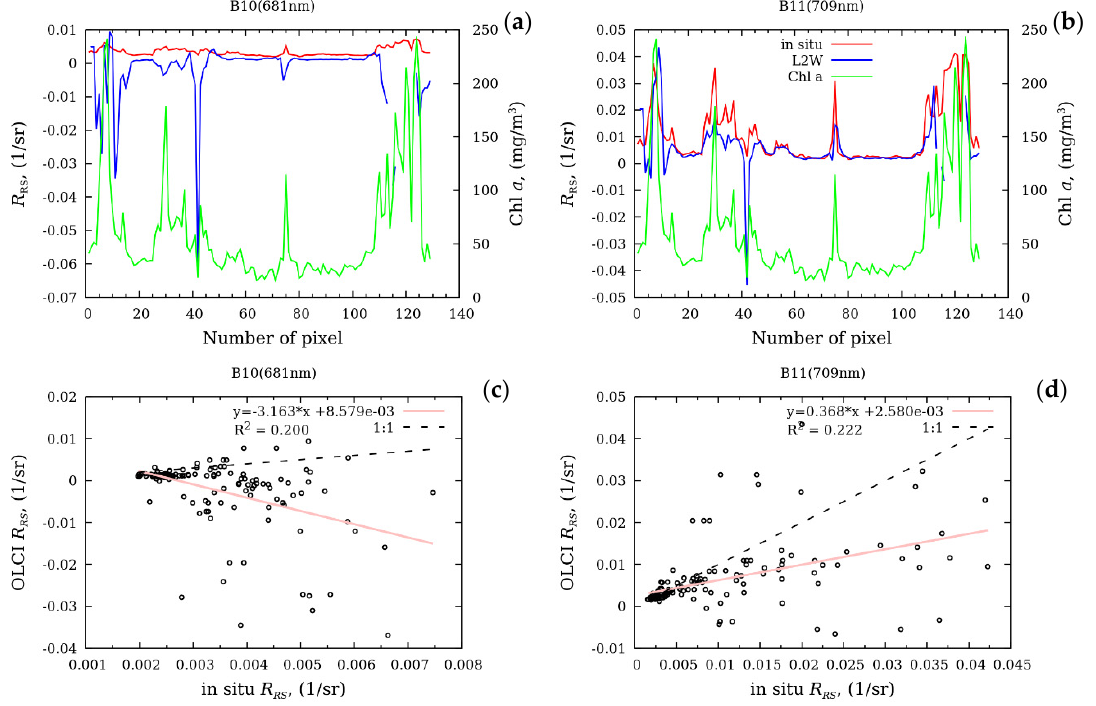
Figure 10. Validation results of L2W-retrieved R rs (blue line) with measured R rs (red line): in B10(681) band ( a ); and in B11(709) band ( b ). The green line is the measured concentration of Chl a along the motorboat route. A scatter plot of OLCI-retrieved R rs and measured R rs : in B10(681) band ( c ); and in B11(709) ( d ). Line 1:1 (dotted line), linear regression (pink line). The number of match-ups is 127.